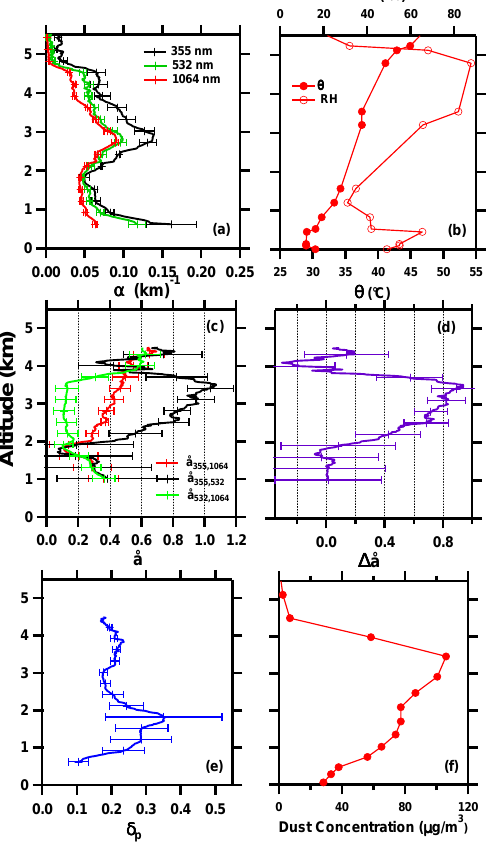
Fig. 8. (a) Extinction coefficient profiles at 355nm (black line), 532nm (green line), and 1064nm (red line) retrieved from li- Figure 8 (M. R. Perrone et al.) 5 dar measurements performed on 5 September 2011 from 14:14 to 14:45UTC. (b) Vertical profiles of potential temperature ( θ) and relative humidity (RH) retrieved from radio sounding measurements performed at 11:00UTC. Vertical profiles of (c) the Ångstrom ex- ponents å 355 , 532 (z) , å 532 , 1064 (z) , å 355 , 1064 (z) , and (d) the spec- tral curvature 1 å (z) . (e) Vertical profile of the linear particle de- polarization ratio (blue line) with corresponding uncertainties (er- ror bars). (f) Dust particle concentration from the BSC–DREAM model.